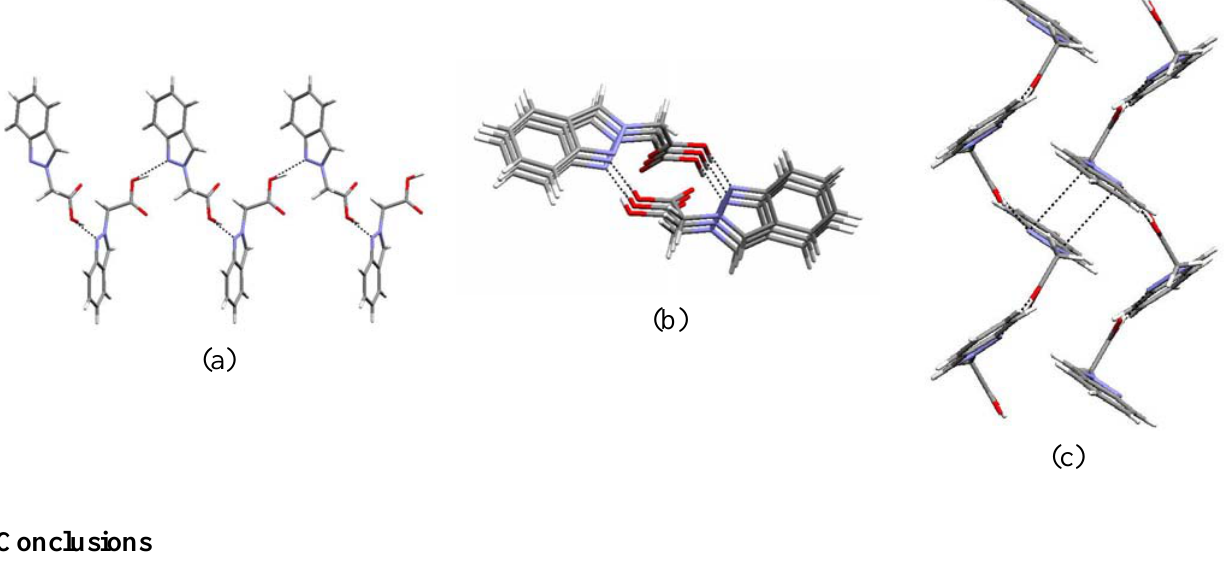
Figure 3. (a) and (b) View along axis a and b respectively, showing the C(6) hydrogen bond synthon, responsible for the zigzag chain. (c) Packing diagram along axis c shows the weak interaction between the zigzag neighbouring chains, due to the π … π contacts (drawings done with Mercury)